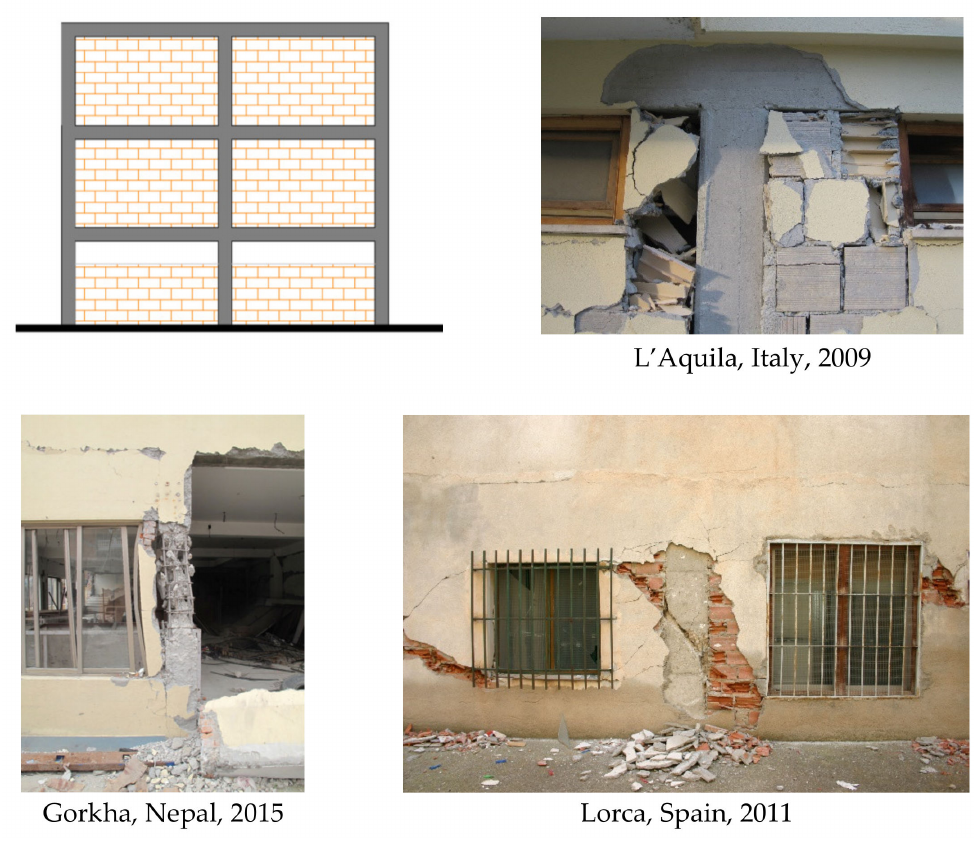
Figure 10. Damage type 6—example of post-earthquake damage in RC structures: short-column mechanism due to adjacent infill panels with